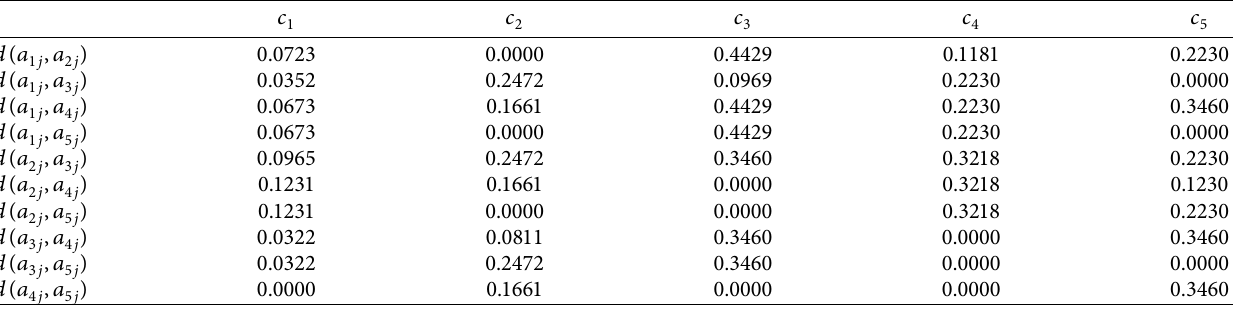
Table 4: The same standard pairwise alternative